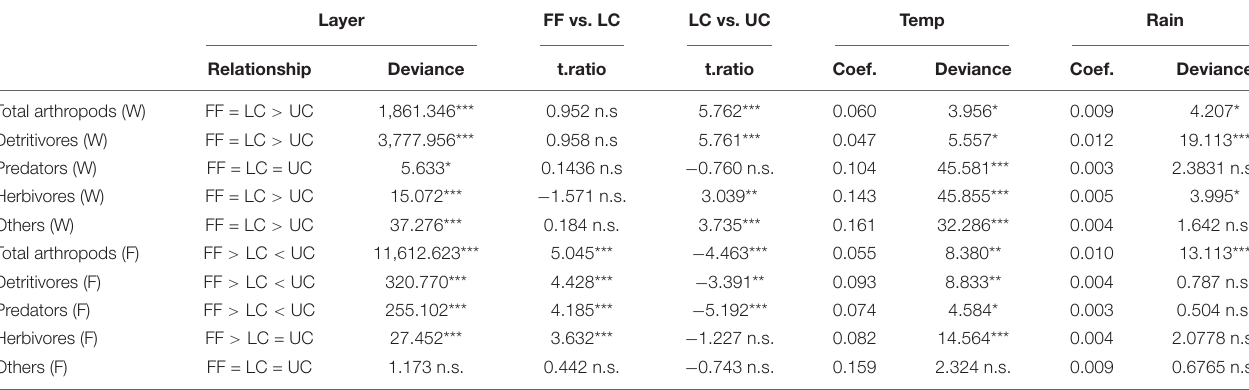
TABLE 1 | Summary results of generalized linear mixed models (GLMMs) that incorporated the effects of trap height (Layer), different layers, temperature (Temp), and precipitation (Rain) on the abundance of feeding groups collected by water-pan traps (a total of 285 samples) in a Japanese cedar ( Cryptomeria japonica ) forest. Layer FF vs. LC